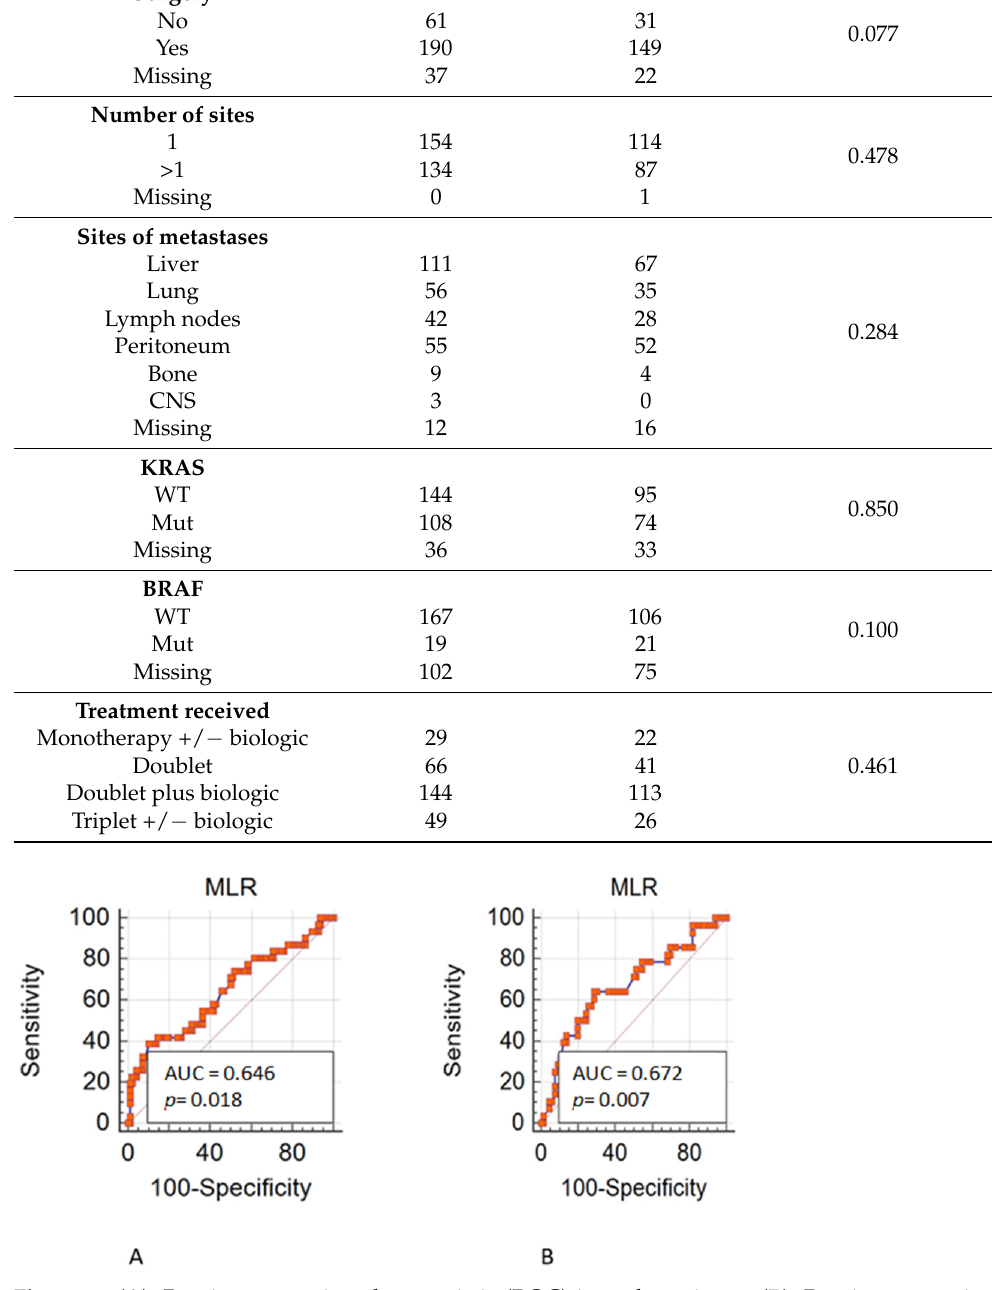
Figure 1. ( A ). Receiver operating characteristic (ROC) in male patients. ( B ). Receiver operating characteristic (ROC) in female patients.